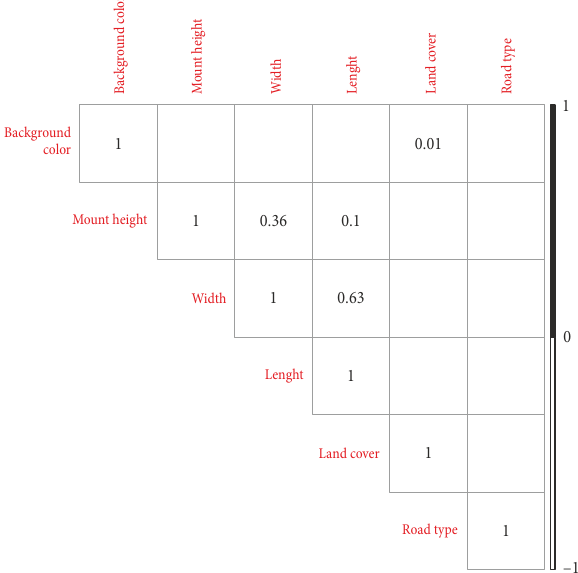
Fig. 7. Pearson correlation coefficient